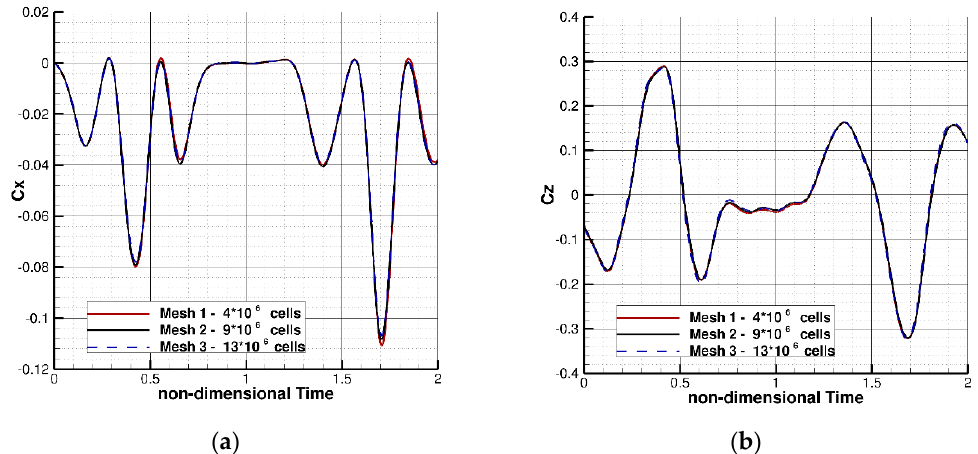
Figure 14. Comparison of the predictions using three different grids: ( a ) Nondimensional forces in the chordwise and ( b ) the normal direction. Force time history is in very good agreement in all of the grids. The coarser grid (red) gives slightly higher C x values at the two peaks, while the other two are almost identical. Consequently, Mesh 2 is used throughout the rest of the study.